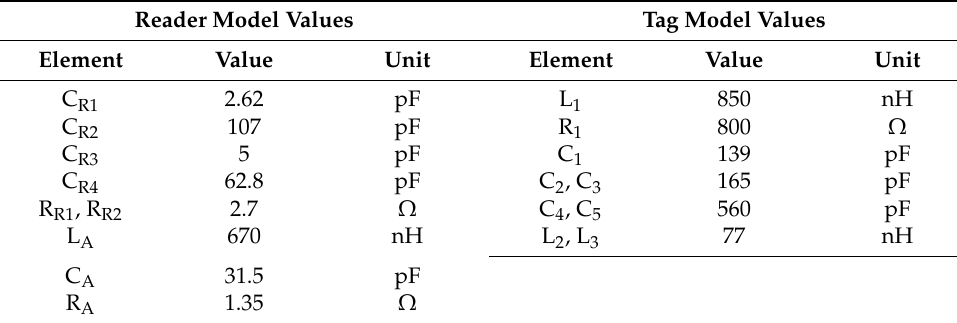
Table 1. Elements values used in models of the reader and the tag.